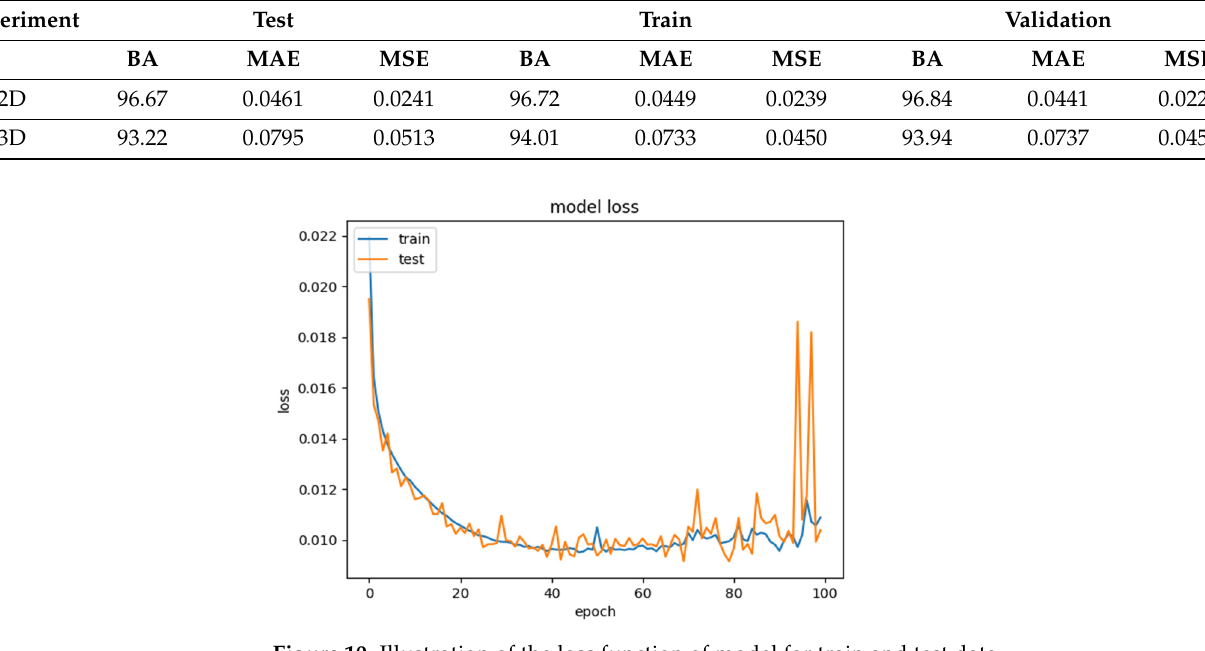
Figure 10. Illustration of the loss function of model for train and test data.